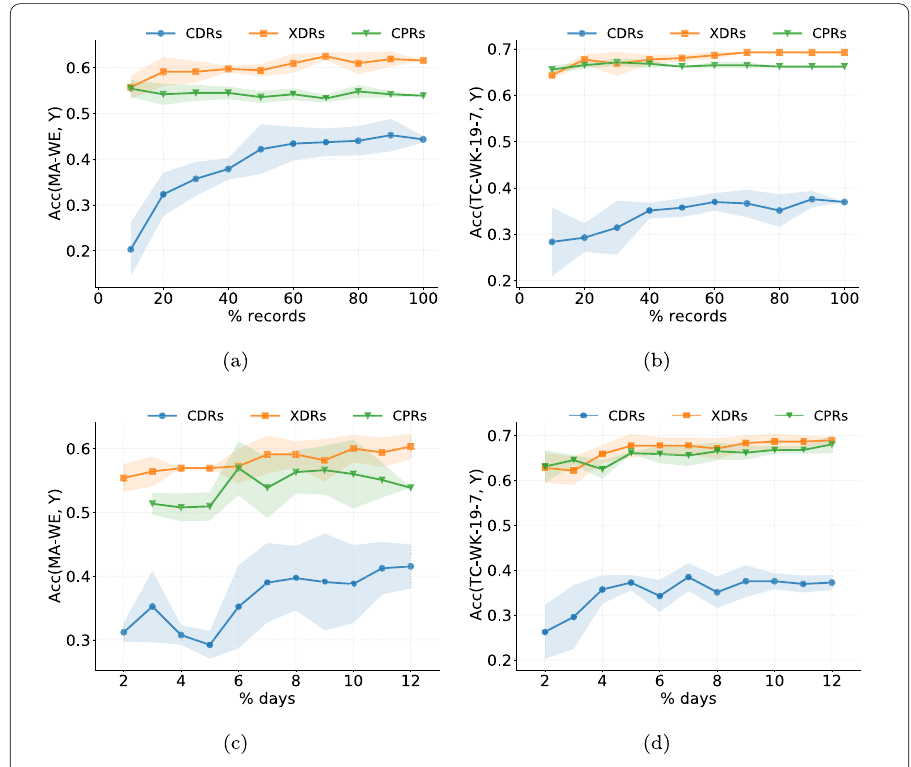
Figure 9 Results of the first data minimization experiment. ( a ), ( c ) Number of records randomly selected versus the average and standard deviation of home detection accuracy ( k = 1, any of the three closest towers) for TC-WK-19-7 and MA-WE. ( b ), ( d ) Number of days randomly selected versus the average and standard deviation of home detection accuracy ( k = 1, any of the three closest towers) for TC-WK-19-7 and